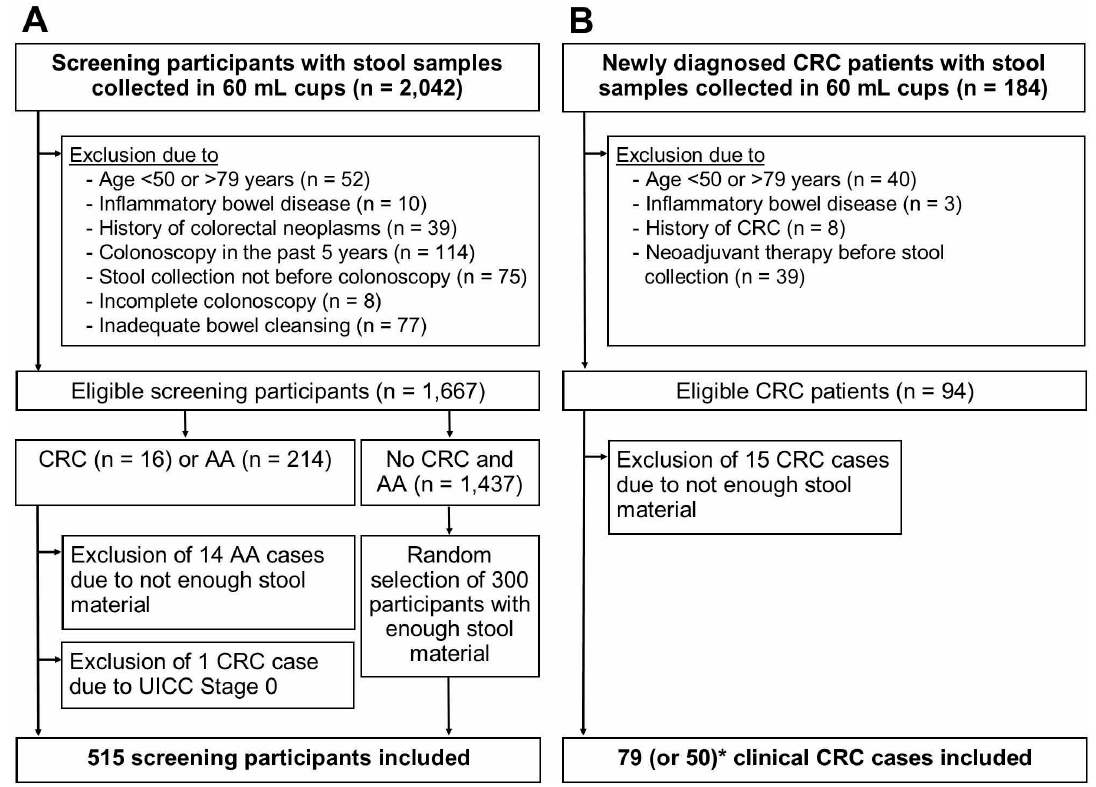
Figure 1. Flow diagram of study participants. ( A ), BLITZ study (screening setting); ( B ), DACHSplus study (clinical setting); *for two FITs (Eurolyser FOB test and OC ‐ Sensor), only 50 CRC cases from DACHSplus were included in the final analysis. Abbreviations: AA, advanced adenoma; CRC, colorectal cancer.